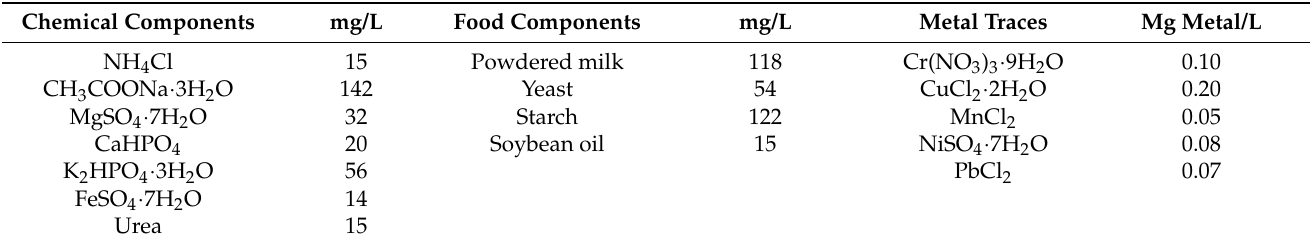
Table 2. The chemical composition of the base synthetic wastewater